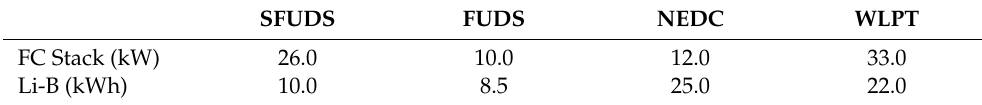
Table 5. H-ESS design solutions (Psplit3): δ =